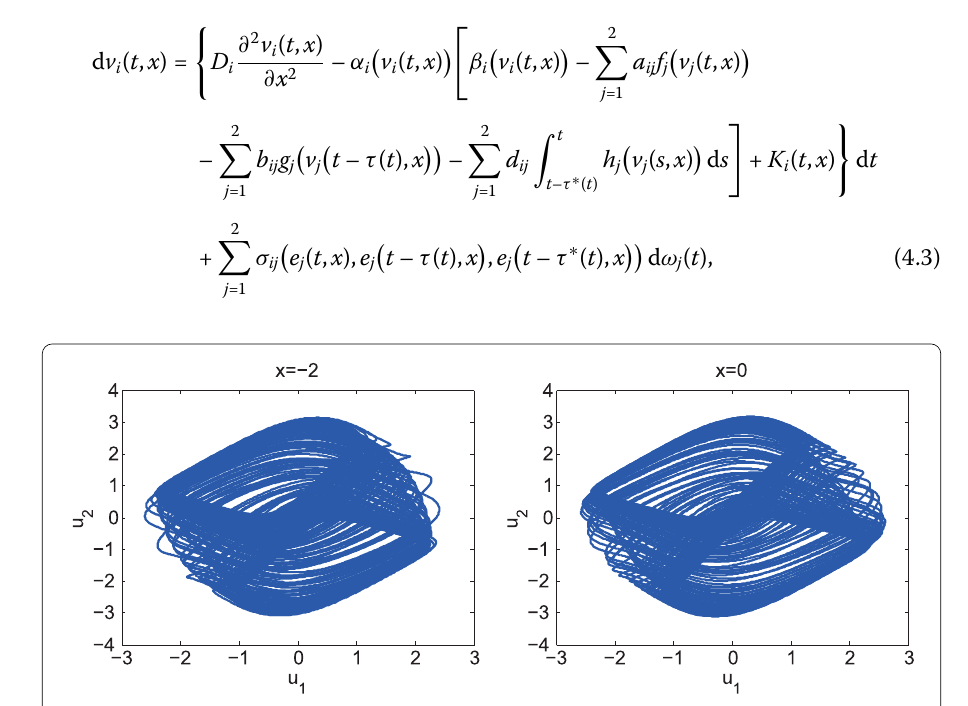
Figure 1 Chaotic behaviors of Cohen-Grossberg neural networks